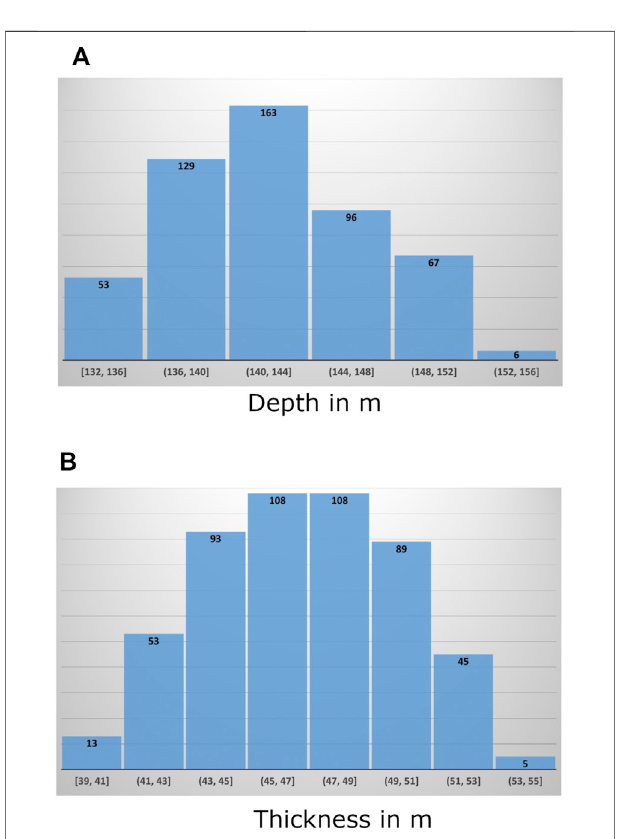
FIGURE13| Northerncontourdepthhistogram: (A) DepthsofPinchout points; (B) Sediment thicknesses above the pinchout contour.